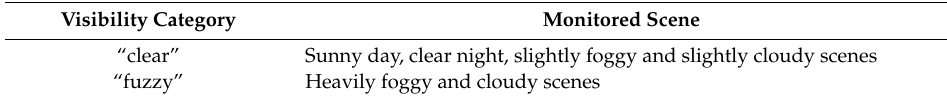
Table 3. Main activity categories and scenes outputted by the BoW-based